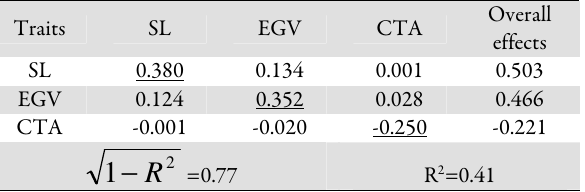
Tab. 6. Direct and indirect effects of third order predictor variables on grain yield by spike length as response